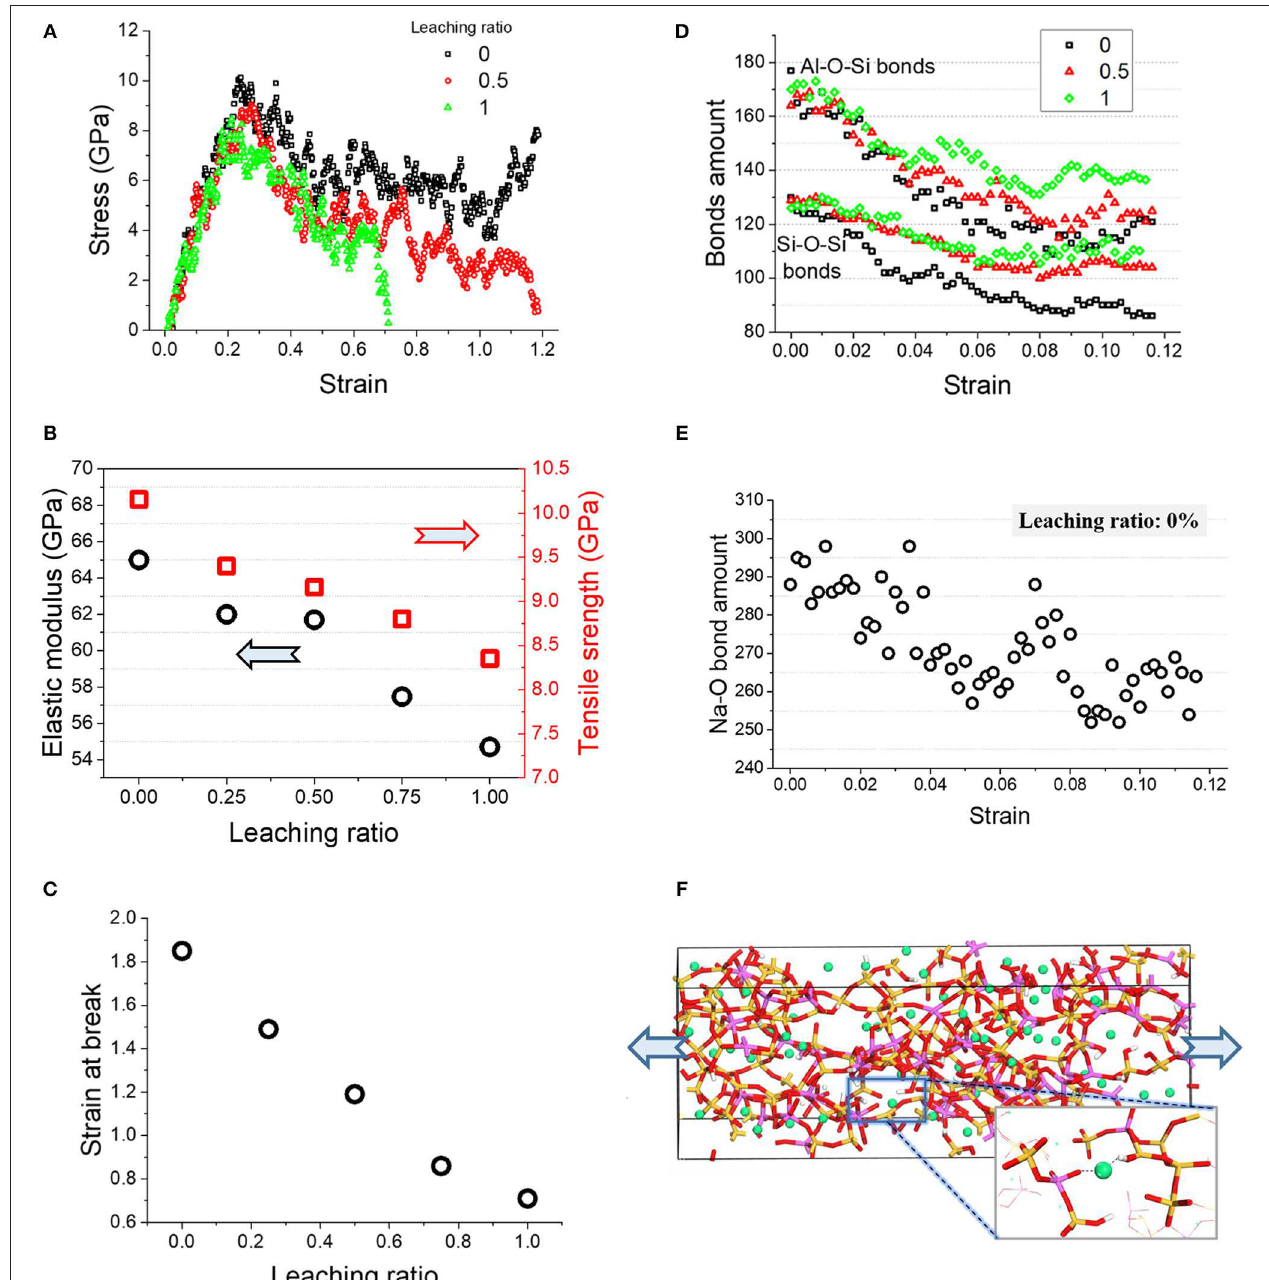
FIGURE 9 | (A) Stress-strain relation of N-A-S-H gels after leaching; (B) tensile strength and elastic modulus, and (C) strain at the breaking point of N-A-S-H; variations of (D) S-O-Si and Si-O-Al bonds and (E) Na-O bond variations as functions of tensile strain; (F) a snapshot of N-A-S-H gel without leaching at a tensile strain of 1. for all samples. The above discussion is related to the pre- peak stage.